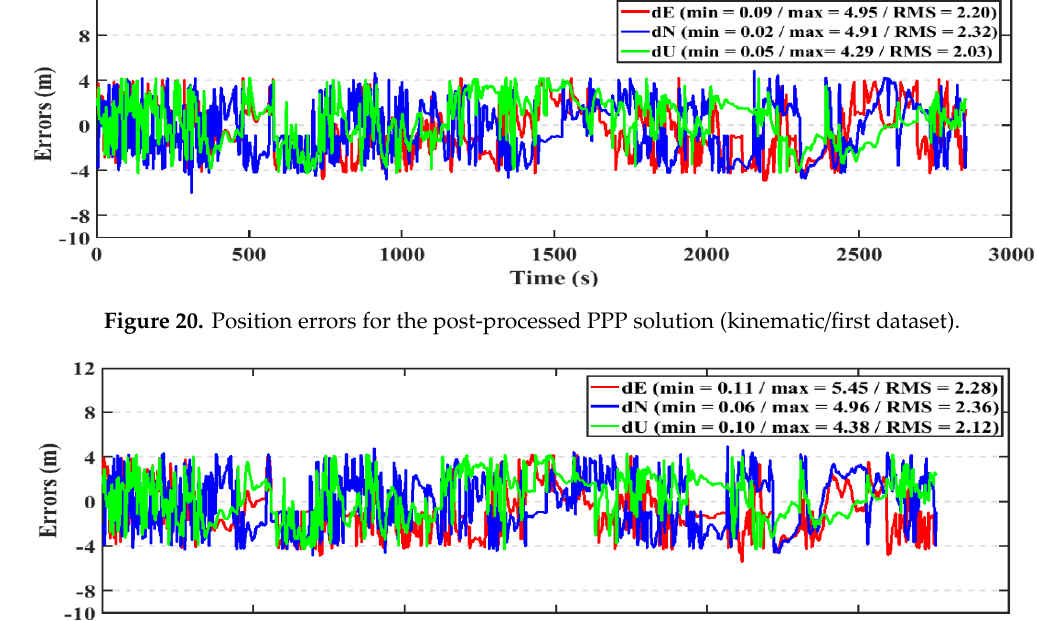
Figure 20. Position errors for the post-processed PPP solution (kinematic/first dataset).